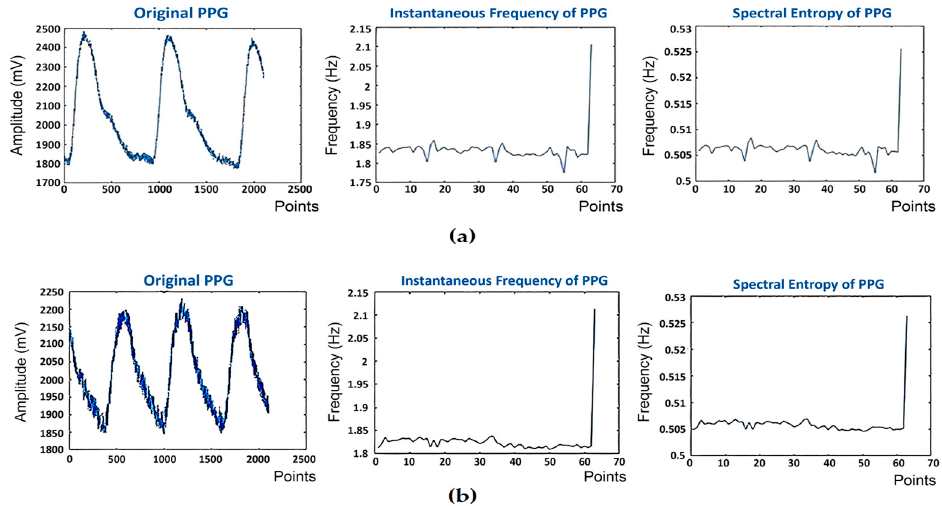
Figure 9. Comparison of the input signal’s structure, original PPG, instantaneous frequency (IF), and spectral entropy (SE) in relation to BGL: ( a ) diabetics; ( b ) normal.